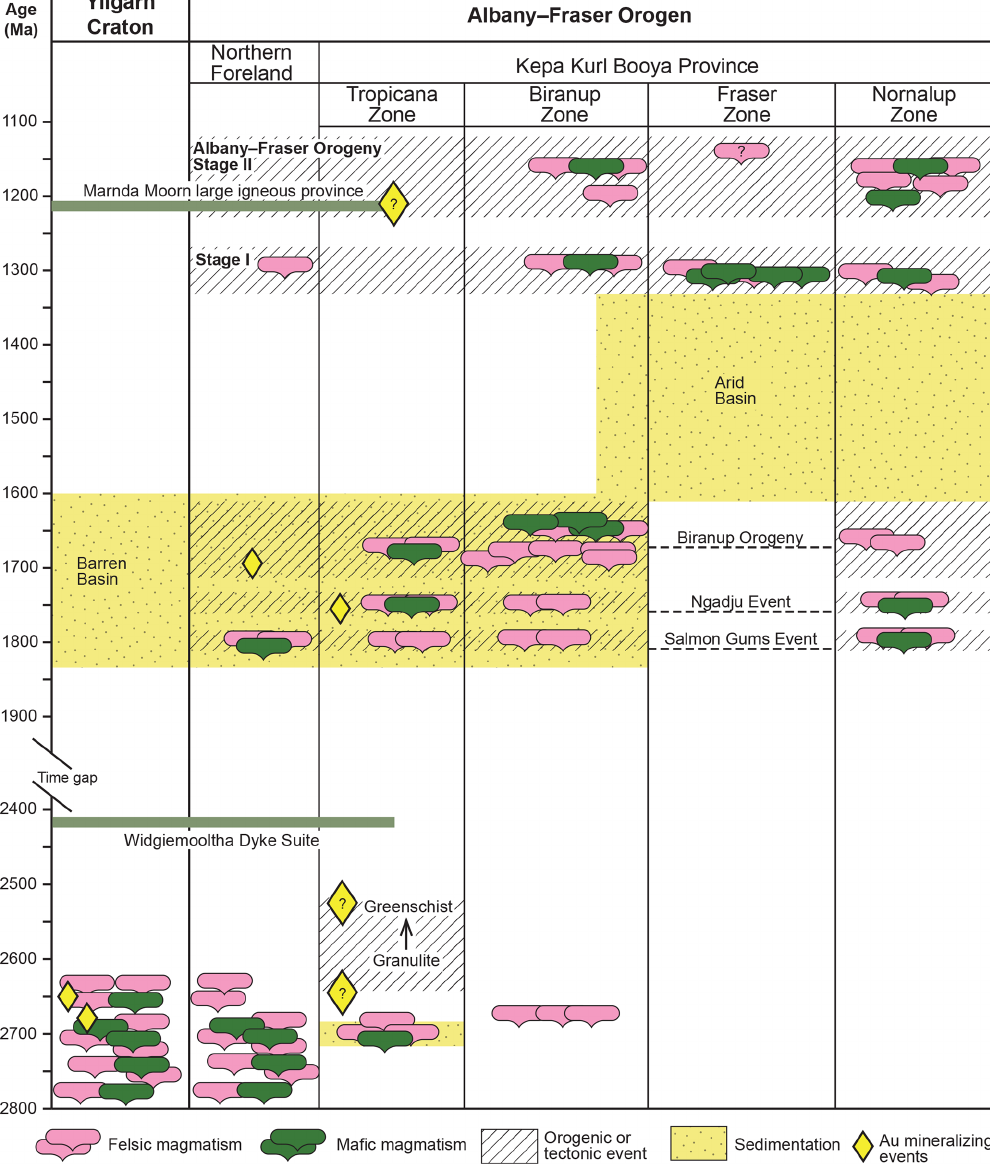
Figure 11. Synthetic time–space plot showing geological history of the Tropicana Zone, modified from Spaggiari et al. (2015) and Kirkland et al. (2015). The timing of mineralization in the Tropicana Zone is uncertain (see Sect.